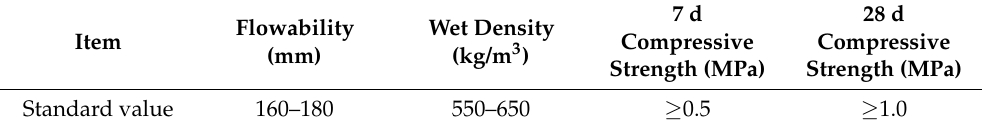
Table 4. Performance of